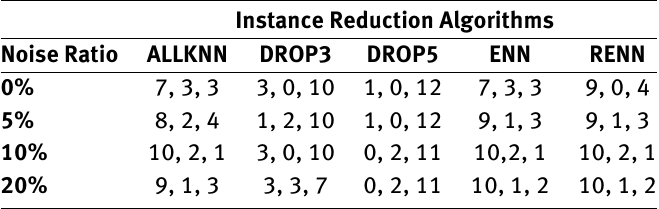
Table 15: Total Number of datasets with affected average accuracy (++, unknown, –) for pruned trees at different noise ratios